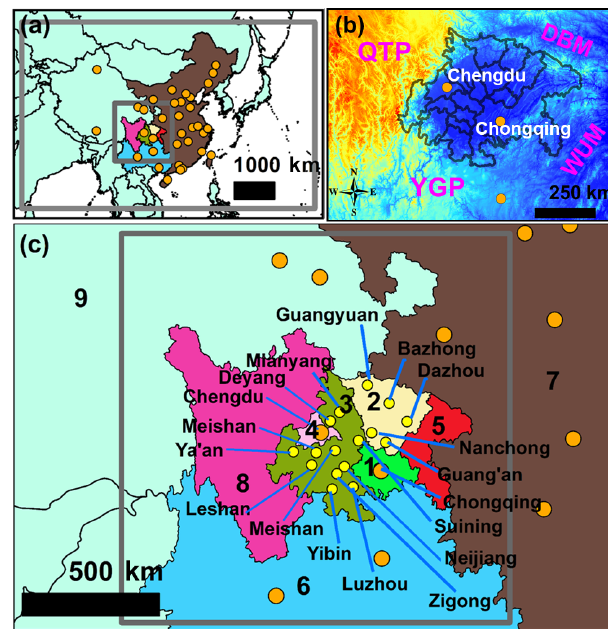
Figure 1. (a) Locations of the 12 and 36km domains (grey rect- angles) and the locations of provincial capitals and municipalities (orange circles), (b) terrain within and surrounding the 18 cities of the SCB (black line), and (c) locations of region categories 1–9 and the prefecture-level cities (yellow circles). Regions 1–5 are the cities within the SCB. Regions 1, 4, and 5 are western Chongqing, Chengdu, and eastern Chongqing, respectively. The city center of Chongqing is located in western Chongqing. Region 8 is the area of Sichuan Province, excluding those cities in the SCB. QTP, Qinghai–Tibetan Plateau; YGP, Yunnan–Guizhou Plateau; DBM, Daba Mountains; WUM, Wu